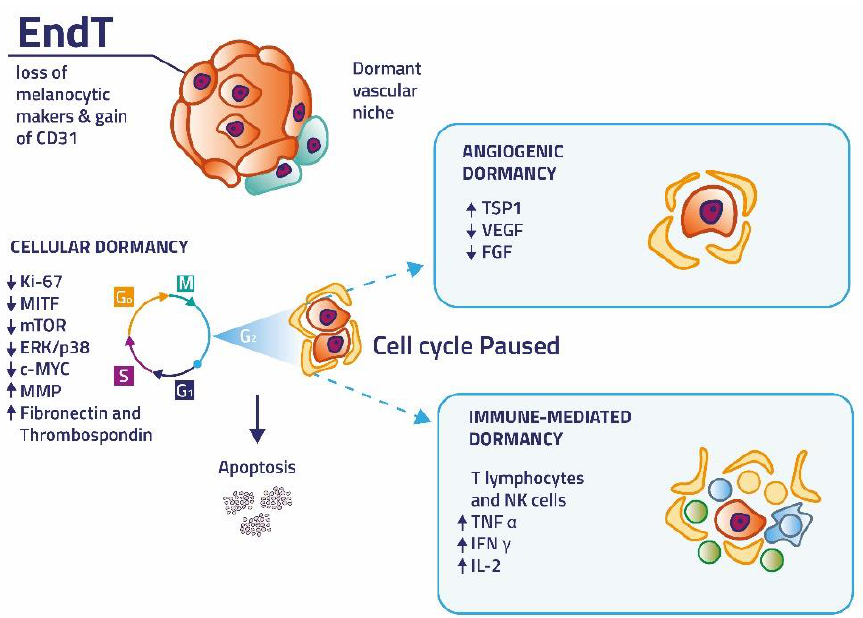
Figure 1. The main factors contributing to the process of melanoma dormancy: cellular dormancy, angiogenic dormancy and immune-mediated dormancy .